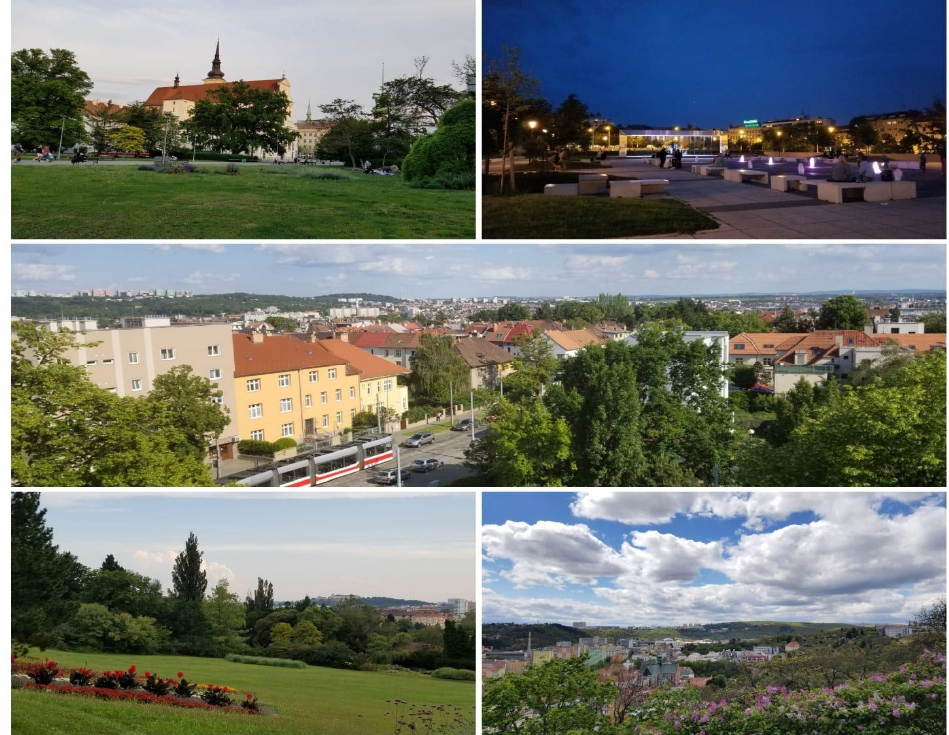
Figure 7. Open spaces and green zones, building and transport integration in Brno (Photos: Dastan Bamwesigye).